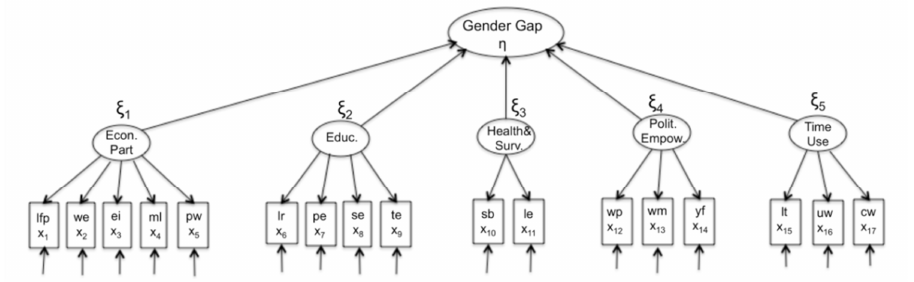
Figure 2 – Path diagram adopted for GGGI with the added Time Use component. Legend